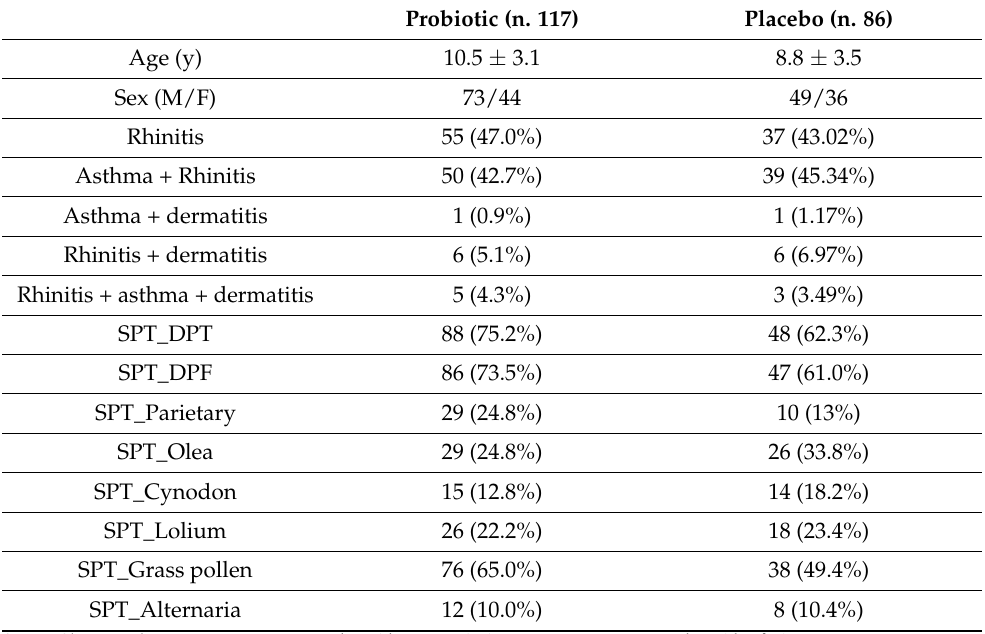
Table 6. Baseline characteristics of the study